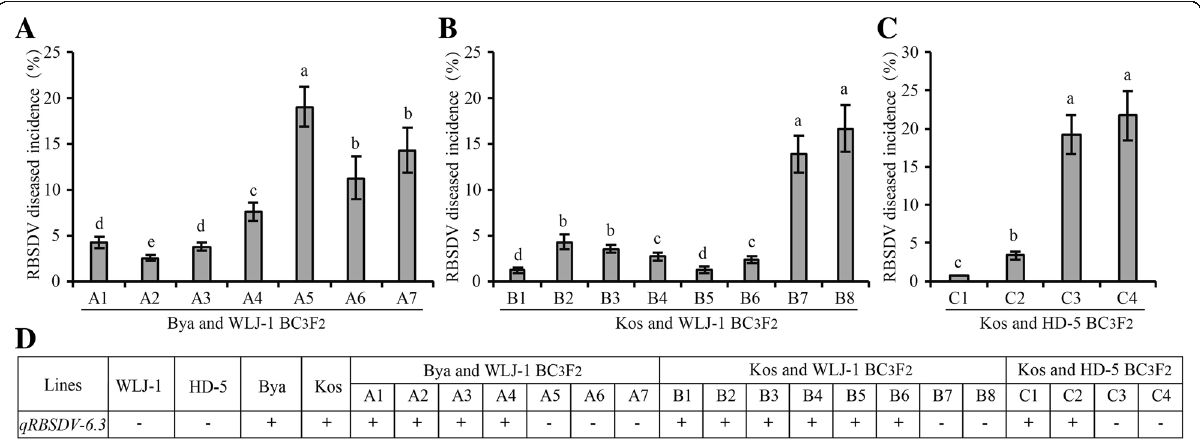
Fig. 6 The RBSDV resistance of introgressed homozygous lines containing qRBSDV-6.3 in three BC 3 F 2 populations. a and b The resistance incidences of different lines from BC 3 F 2 populations by the backcross between Bya ( a ) or Kos ( b ) with WLJ-1, using Kos as the recurrent parent. c The resistance incidences of different lines from a BC 3 F 2 population by the backcross between Kos with HD-5, using Kos as the recurrent parent. d The presence (+) or absence (-) of qRBSDV-6.3 in different lines from three BC 3 F 2 populations. Bya, Byakkoku Y 5006 Seln; Kos, Koshihikari. Letters above columns indicate 5% statistically significant